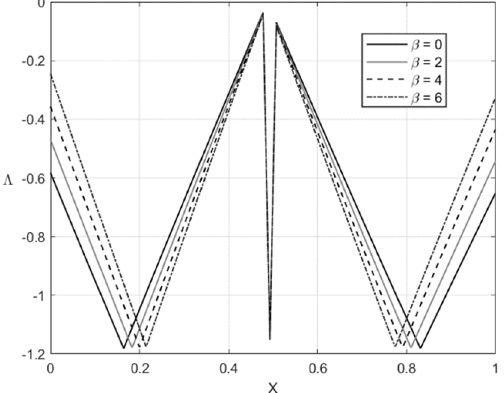
Figure 12. Through-thickness distribution of the residual stress 0.2 f = , and several values of β .